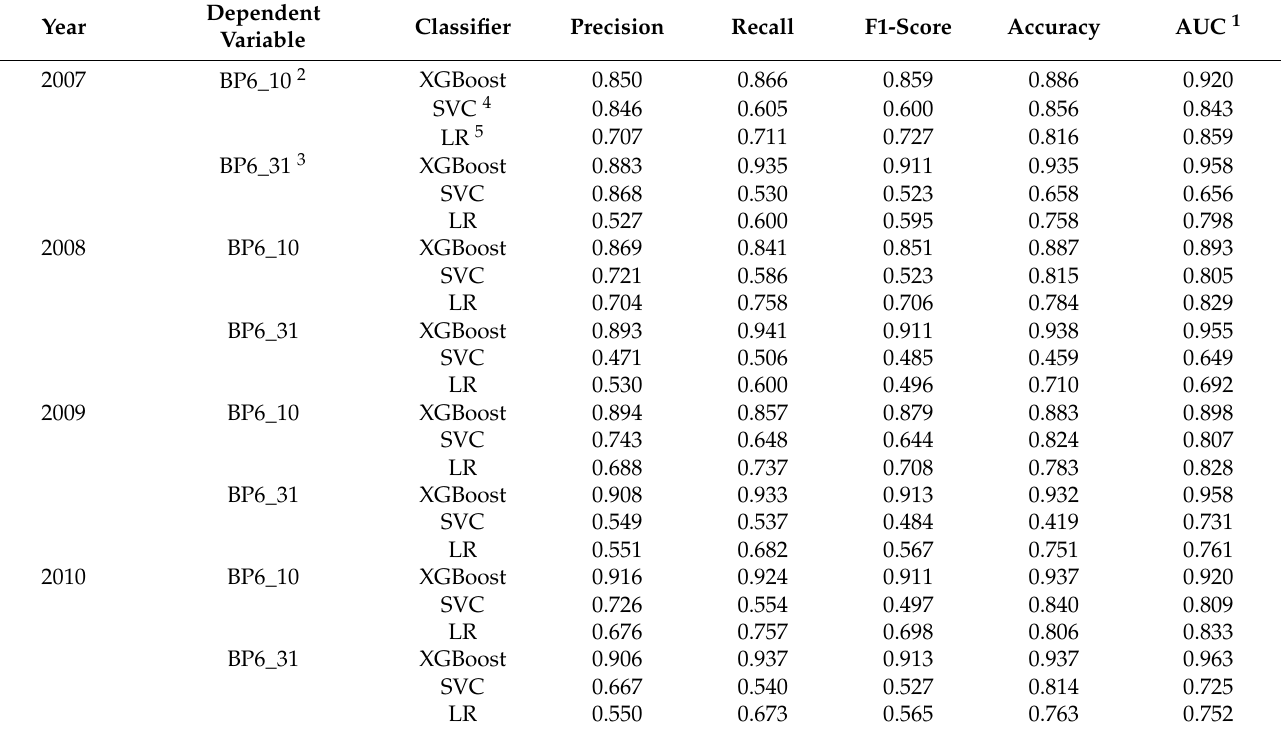
Table 5. Classification performance results for classifiers with yearly datasets